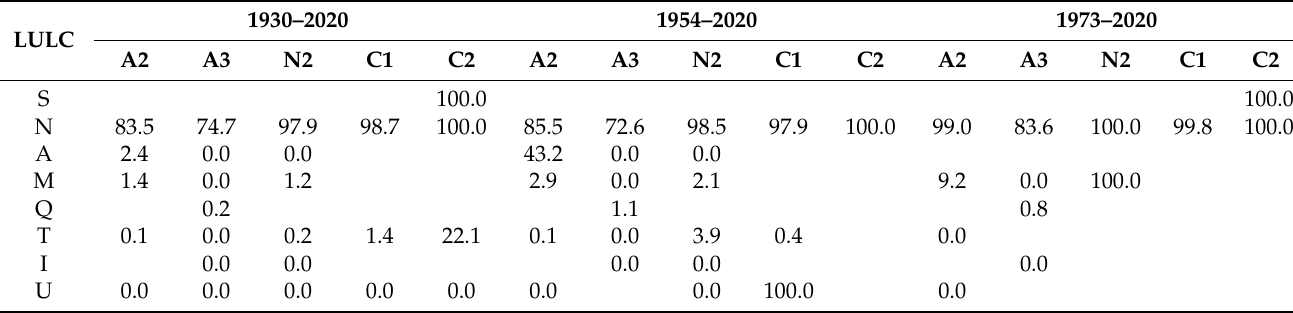
Table 5. Area (%) of each LULC class of the abandoned areas of 1930, 1954, and 1973 active channels (Figure 10) that is included within the macrochannel. Reaches A1 and N1 were not considered as they do not display the macrochannel. Zero indicates that the active-channel abandoned areas showing the LULC class which this value refers to are not included within the macrochannel; the absence of value indicates that no active-channel abandoned areas showing the LULC class which the null value refers to were mapped in the whole reach.